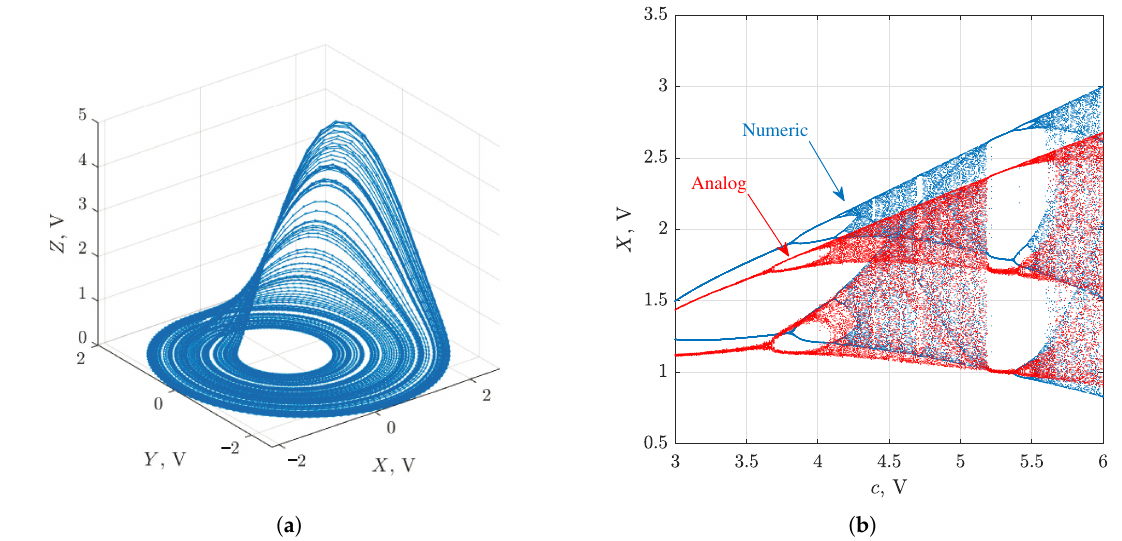
Figure 7. ( a ) Attractor produced by the circuit. ( b ) Bifurcation diagrams of overlaid numerical (Runge–Kutta 4) and analog systems. Parameter b = 0.2 was used for the numerical system, and parameter b = 0.3 for the analog